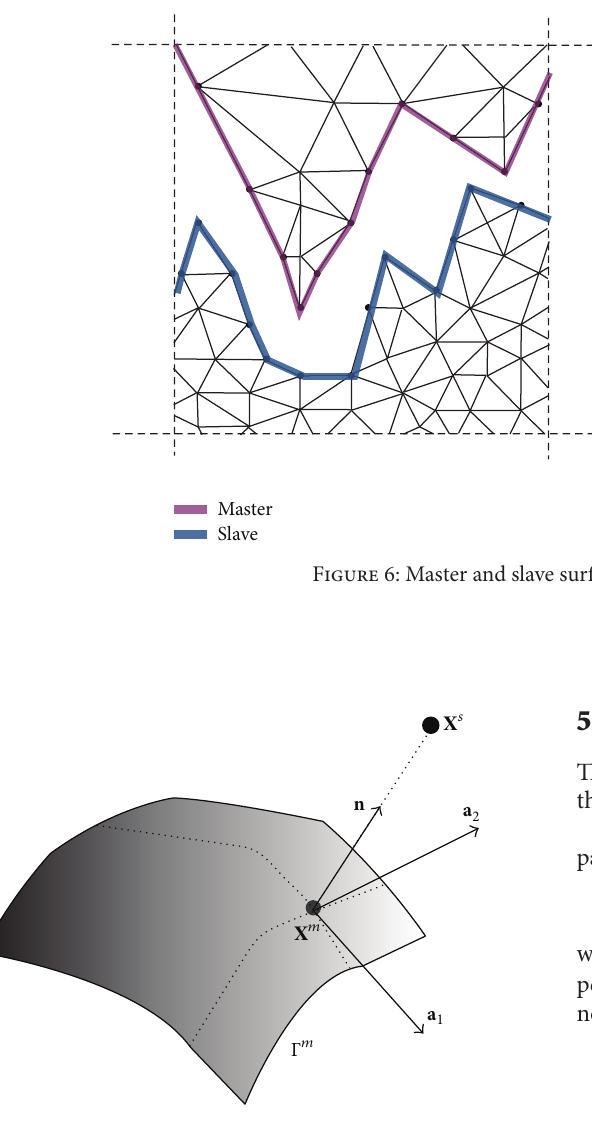
Figure 7: Definition of the normal direction in a point and location of a master